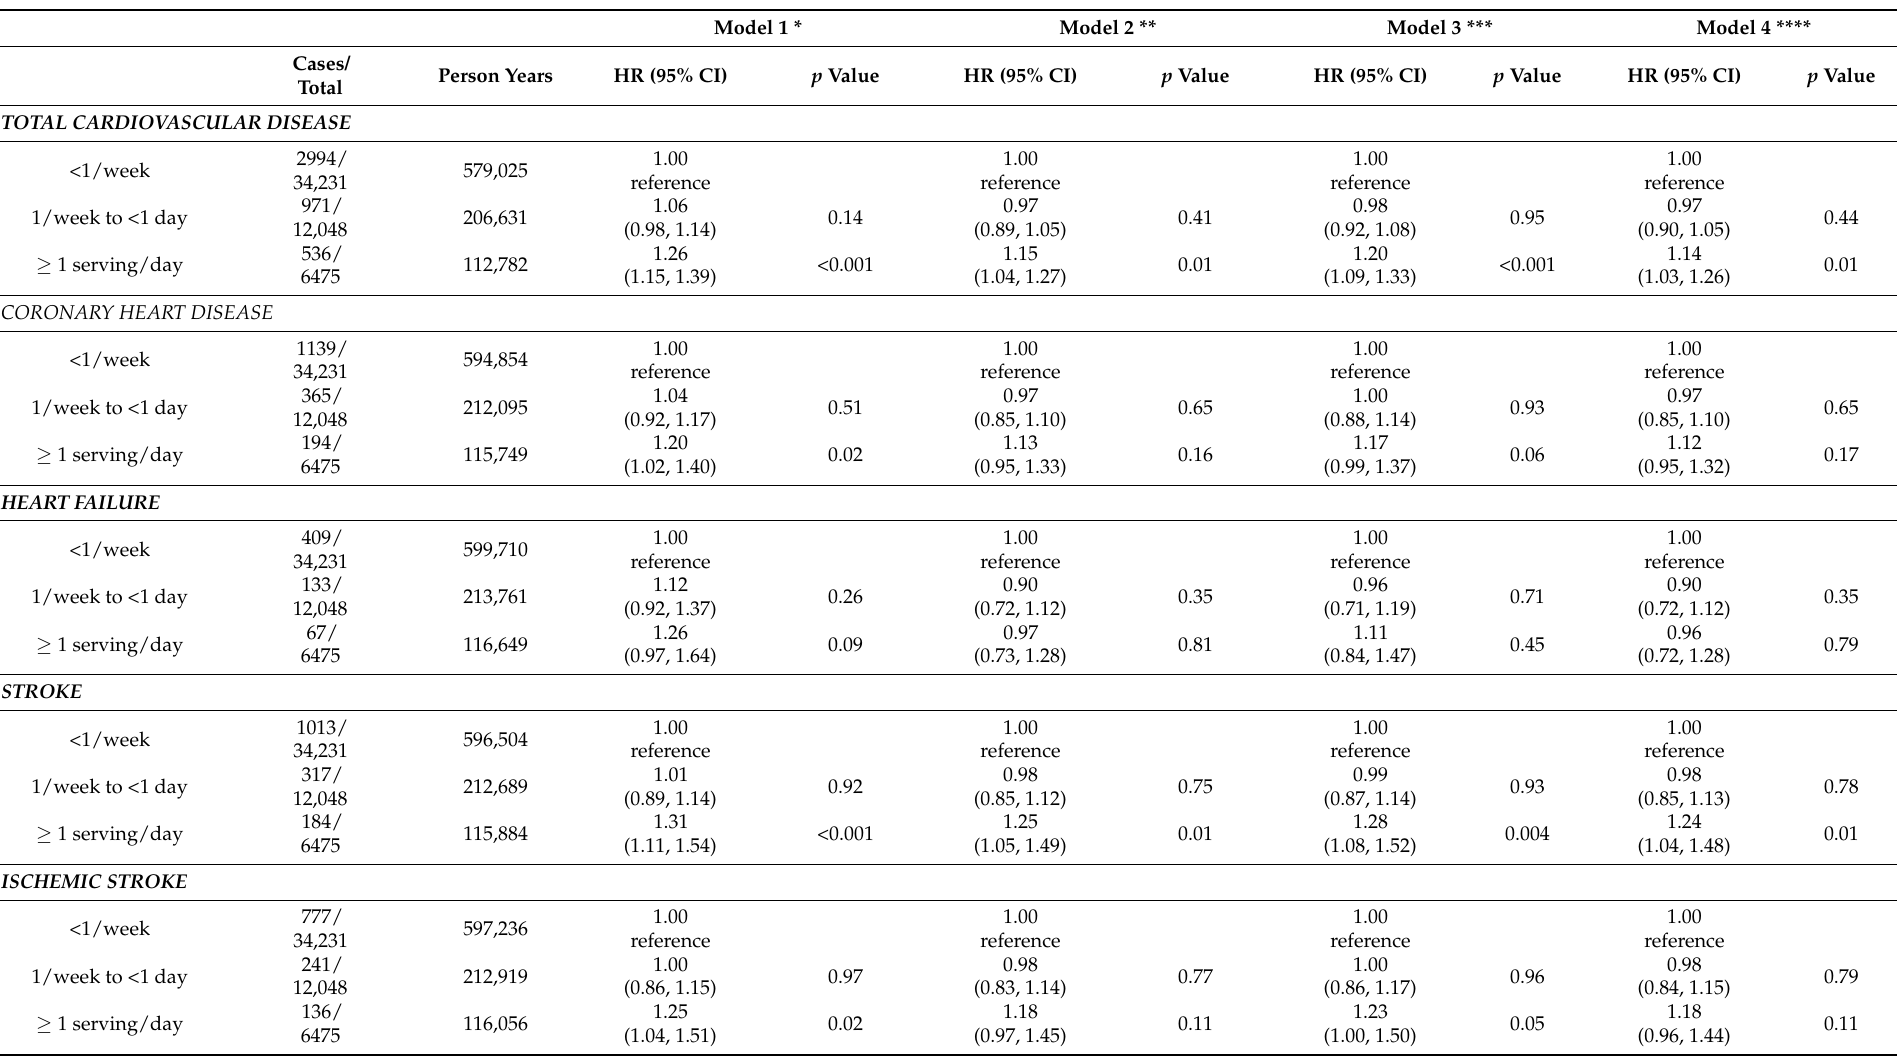
Table 4. Prospective association of ASB servings with risk of cardiovascular disease outcomes among 52,754 participants in the Women’s Health Initiative (OS)